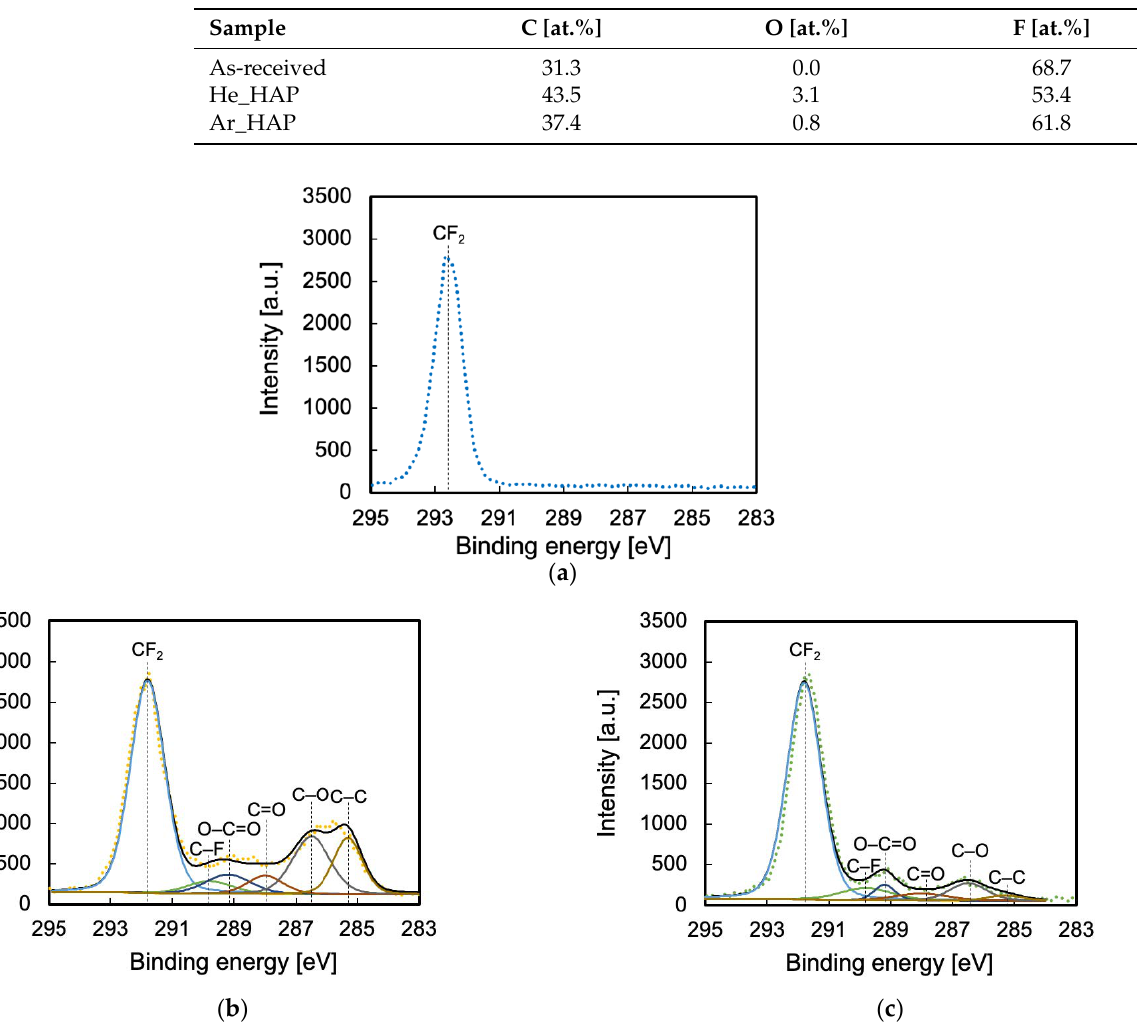
Table 1. Atomic ratios of the PTFE samples HAP-treated using He or Ar gas.